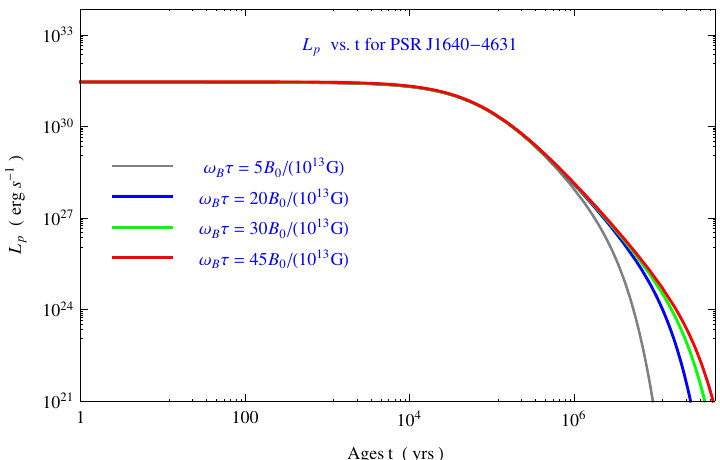
Figure 7. The dipolar magnetic field decay rate L p as a function of t for PSR J1640-4631 with n >